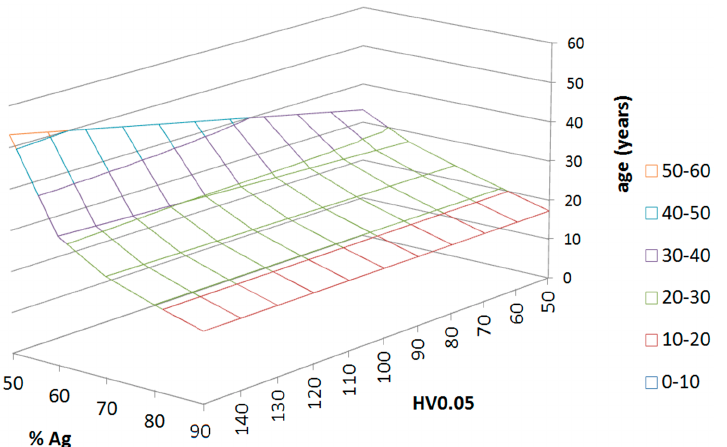
Figure 7. Determination of the age of the sample based on the silver content and micro-hardness at the value of Meyer’s index n = 2. the value of Meyer’s index n =